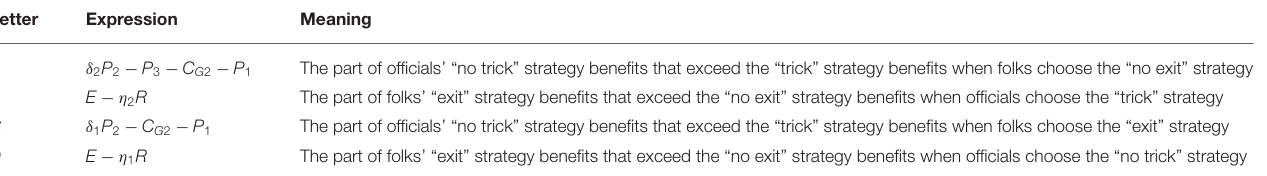
TABLE 3 | Meaning of letters. Letter